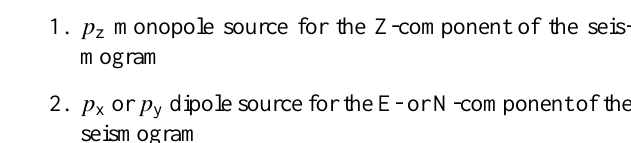
Fig. 6. Nominal ray paths of regional P -waves in IASP91 . None of the rays bottom in the lower part of the transition zone. Contrast this to the realistic (finite-frequency) sensitivities of 5, which extend broadly across the entire MTZ.